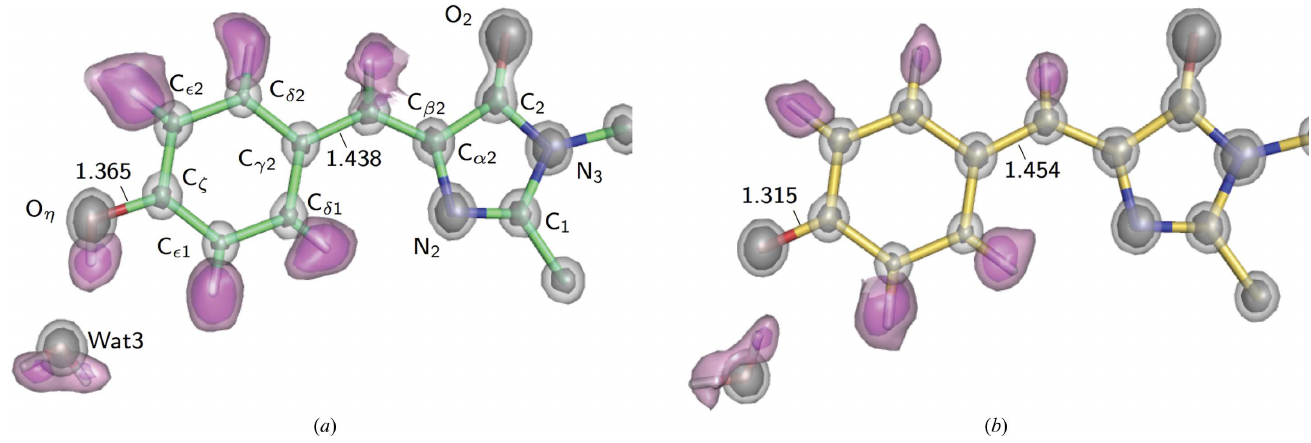
Figure 3 X-ray analysis of GFP from A. victoria . ( a ) Electron density for the T203I variant. The 2 F o (cid:5) F c map contoured at 4 (cid:5) and 6 (cid:5) and the F o (cid:5) F c OMIT map for H atoms contoured at 2 (cid:5) and 3 (cid:5) are shown in gray and pink, respectively. The values shown in the figures are the C (cid:9) —O (cid:10) and C (cid:3) 2 –C (cid:11) 2 bond lengths in A˚ . ( b ) Electron density for the E222Q variant.